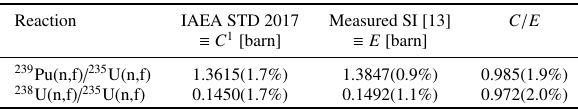
Table 4: Fission SI in Flaptop-U (HEU-MET-FAST 028 [14]) critical